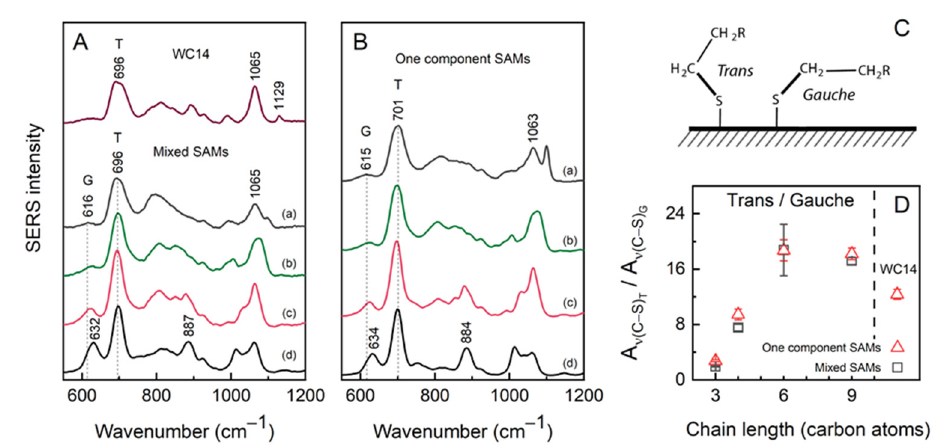
Figure 4. ( A ) SERS spectra of Ag adsorbed WC14 (top curve) and mixed SAMs containing different backfillers and ( B ) one component SAMs. The order of curves is 9M1N (a), 6M1H (b), 4M1B (c), 3M1P (d). Letter G and T denote gauche and trans conformation. ( C ) Schematic representation of surface adsorbed thiol molecules in the gauche and trans conformation. The conformation was defined by the dihedral angle of the –S–C– bonding ( D ) T/G ratio dependence on the chain length in carbon atoms of backfiller. The composition of mixed SAMs was 80% backfiller and 20% WC14. Mean ± SD were calculated from 3 measurements.